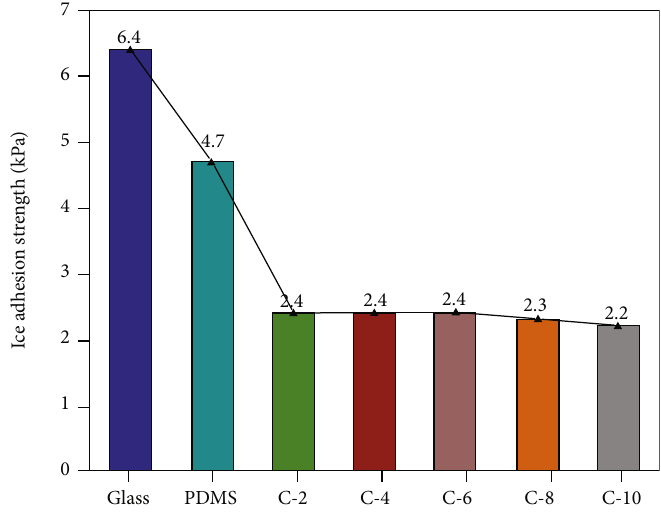
Figure 4: The test results of ice adhesion strength.